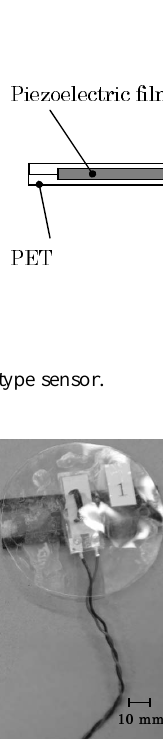
Figure 2. Overview photograph of prototype sensor.